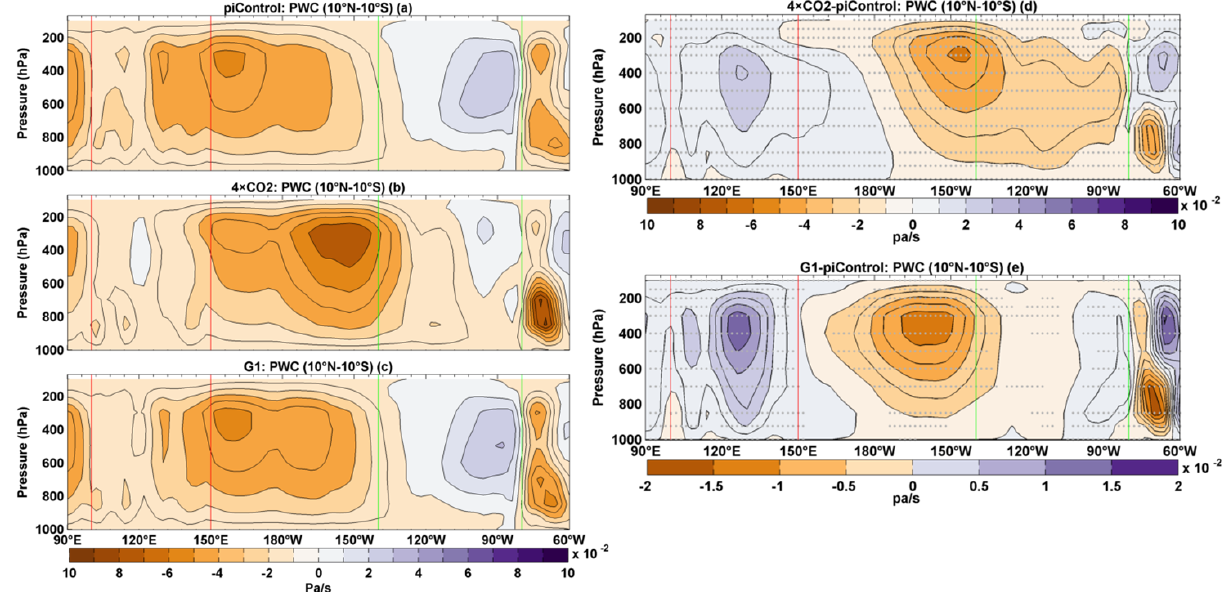
Figure 6. Mean DJF climatology of tropical Pacific Walker Circulation averaged over 90 ◦ E–60 ◦ W and 10 ◦ N–10 ◦ S: (a) piControl, (b) 4 × CO 2 , (c) G1, (d) 4 × CO 2 − piControl difference, and (e) G1 − piControl difference. Green (red) vertical lines show the longitu- dinal spread of the eastern (western) Pacific. Stipples indicate grid points where the difference is statistically significant at 99%cl using a non-parametric Wilcoxon rank-sum test. Table 5. Niño3 SST skewness. Experiment Skewness Difference w.r.t. SD 10000 ∼ Change w.r.t. piControl realizations piControl (%) piControl 0.52 ∗ 0.0542 4 × CO 2 − 190